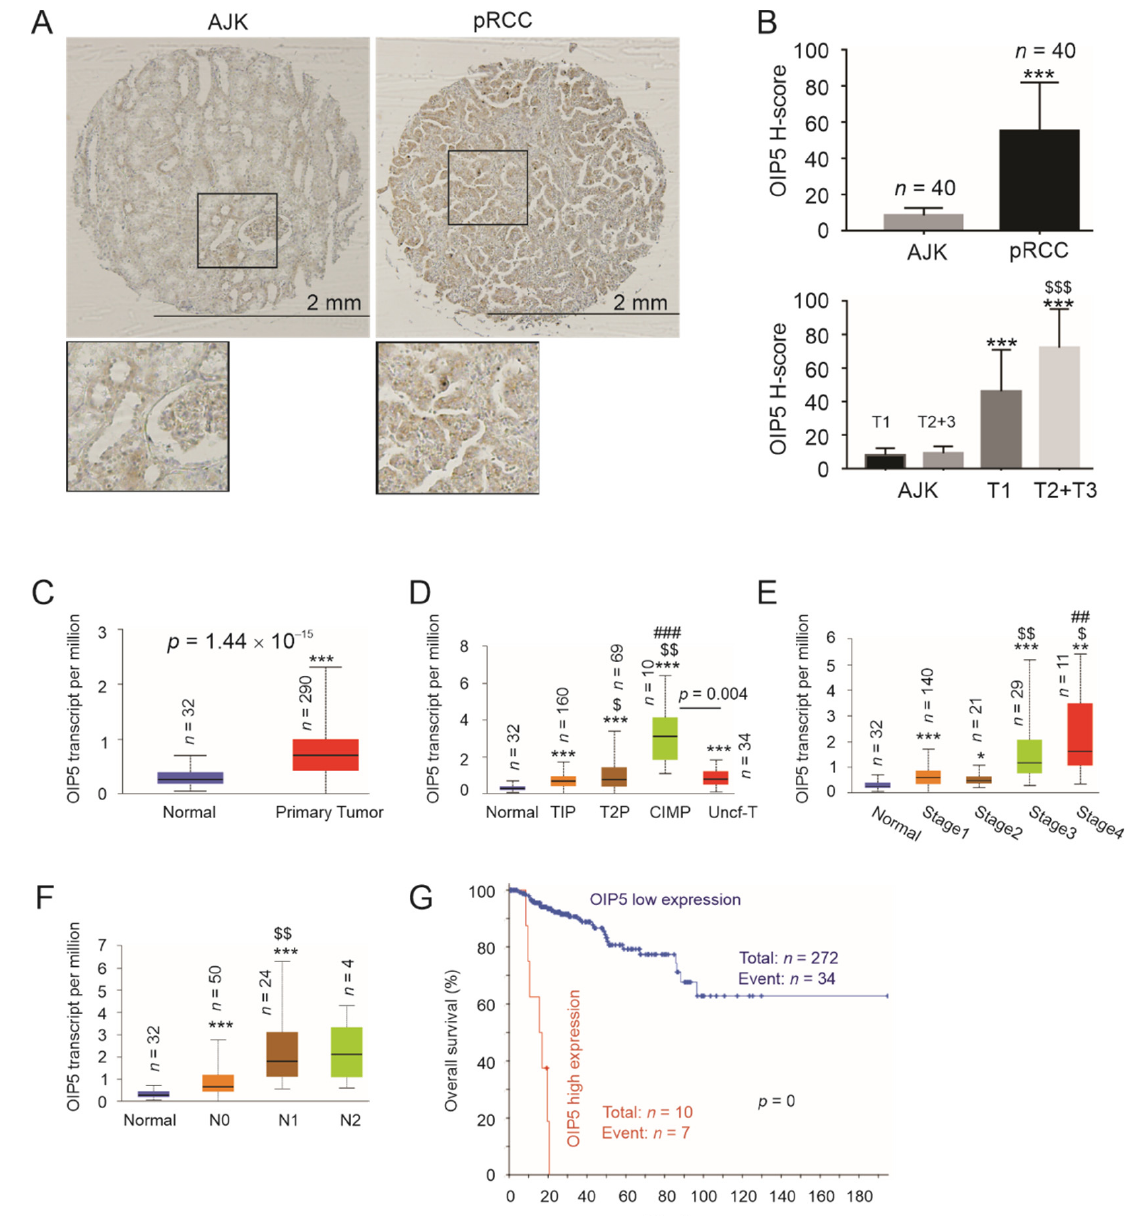
Figure 1. Upregulation of OIP5 associates with adverse features of pRCC and predicts poor overall survival. ( A ) IHC staining for OIP5 was performed using a RCC TMA; typical images of OIP5 staining in the adjacent kidney (AJK) and pRCC tumor tissues are presented. ( B ) Quantification of OIP5 IHC staining by H-score in the indicated tissues; means ± standard deviations (SDs) are graphed. Statistical analyses were performed using 2-tailed Student’s t -test; ***: p < 0.001 compared to the respective AJK tissues, $$$: p < 0.001 compared to T1 tumors. ( C – F ) OIP5 mRNA expressions in the indicated setting were analyzed using the TCGA dataset organized by UALCAN [37]. Student’s t -test ( C ) and other indicated paired